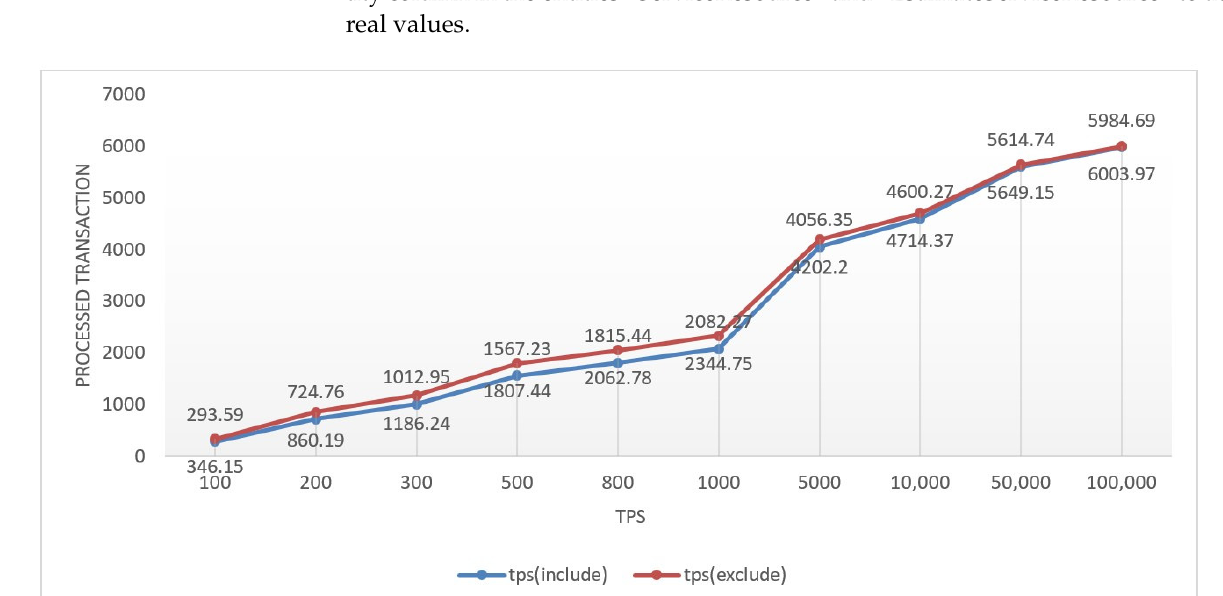
Figure 11. Graphical representation of the simulation order processing process (TPS).